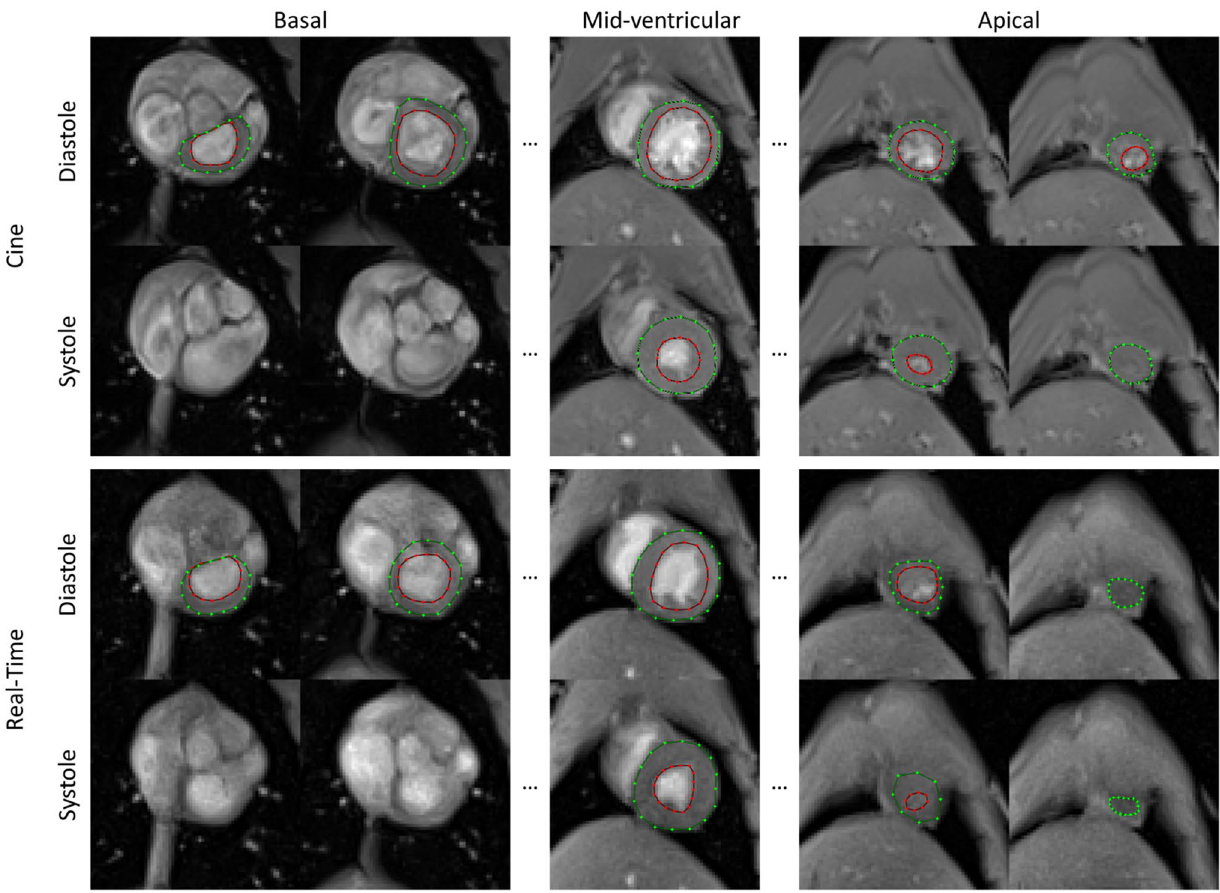
Figure 1. Qualitative comparison of cine MRI and RT-MRI. Compared to cine MRI (top), RT-MRI (bottom) exhibited a reduced image sharpness making the demarcation of the papillary muscles and the trabeculae challenging. Epicardial and endocardial delineations are marked in green and red, respectively. All images were acquired during